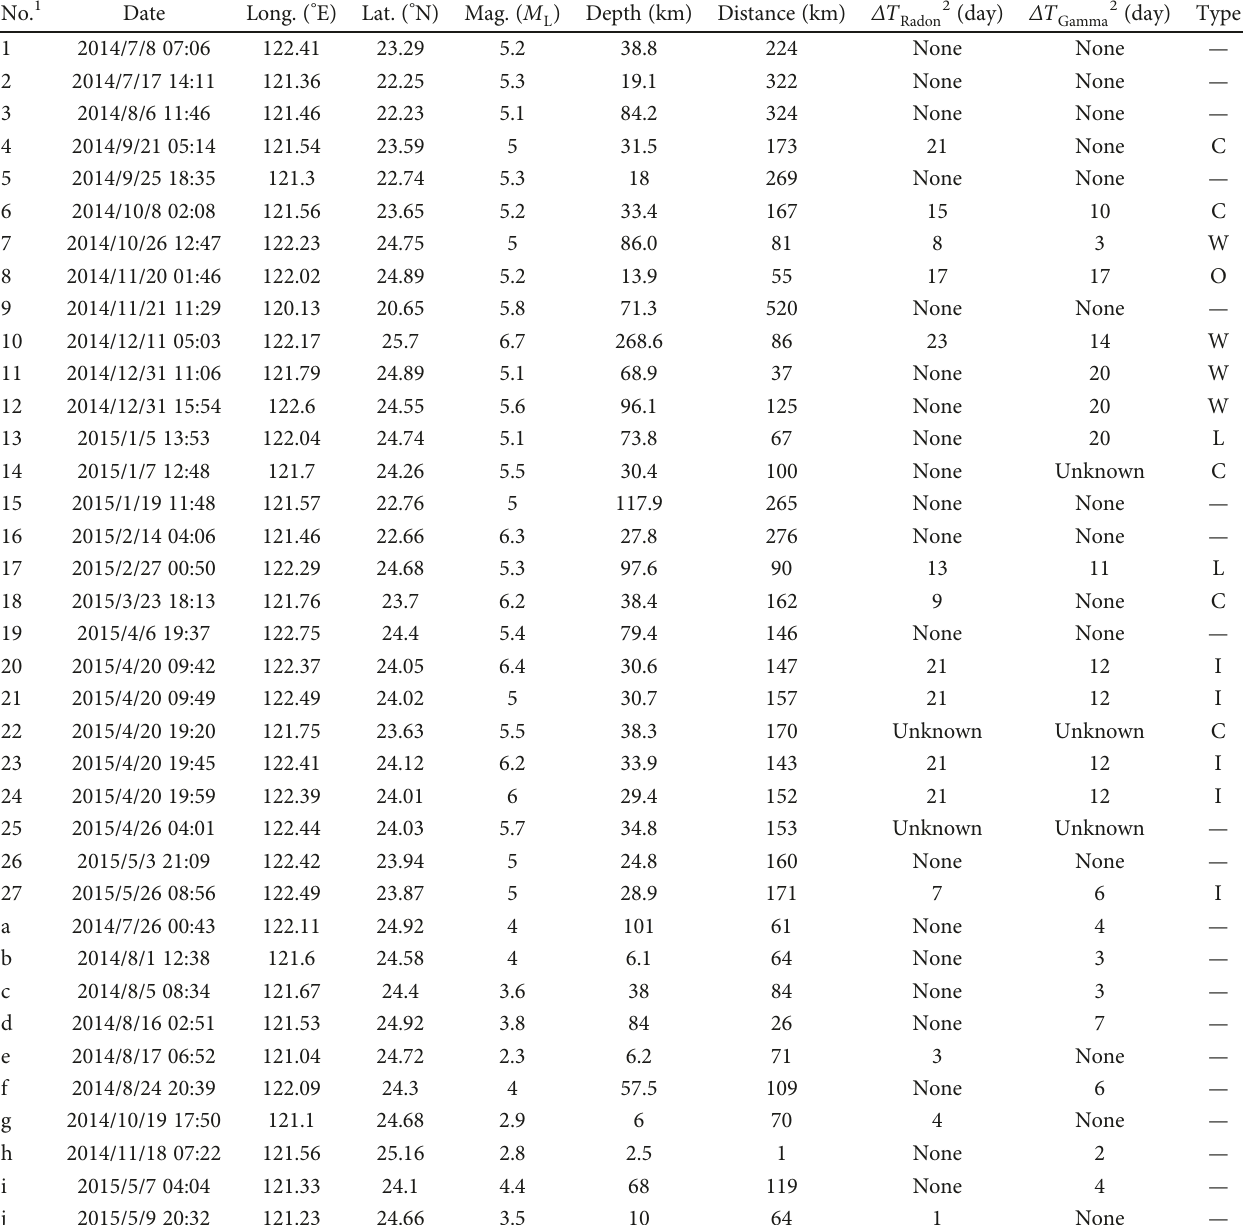
Table 2: Catalog of gamma ray and radon anomalies and related earthquakes occurring in Taiwan from July 1, 2014, to June 1, 2015. No.